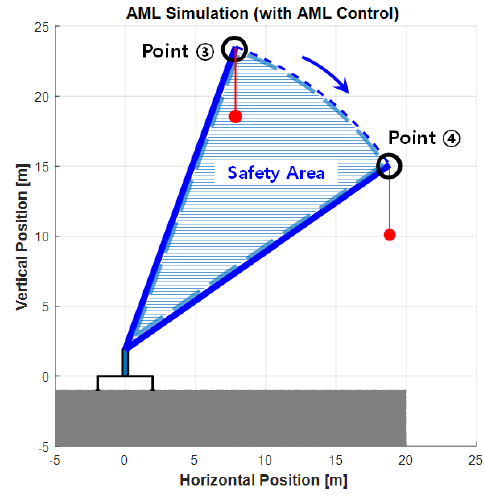
Figure 11. AML simulation outputs with control.